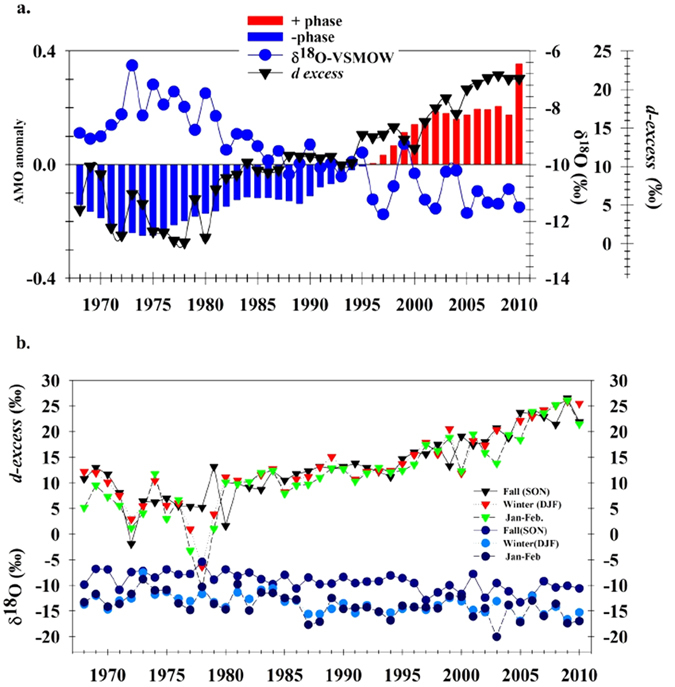
Response of HBEF precipitation δ18O and d-excess values during the study period to AMO phase changes.(a,b) Average, de-trended AMO anomalies (oC) from the Kaplan sea surface temperature V2 from http://www.esrl.noaa.gov/psd/data/timeseriesimeseries/AMO), δ18O = −6.78AMO-9.90, r2 = 0.7 and d-excess = 35.3AMO + 12.4, r2 = 0.83 (a) and comparison of fall precipitation δ18O (blue dots) and d-excess value (black triangle), winter precipitation δ18O (light blue dots) and d-excess value (red triangle) with a precipitation δ18O of January-February (dark blue) and d-excess value (green triangle) over the 1968–2010 study period (b).